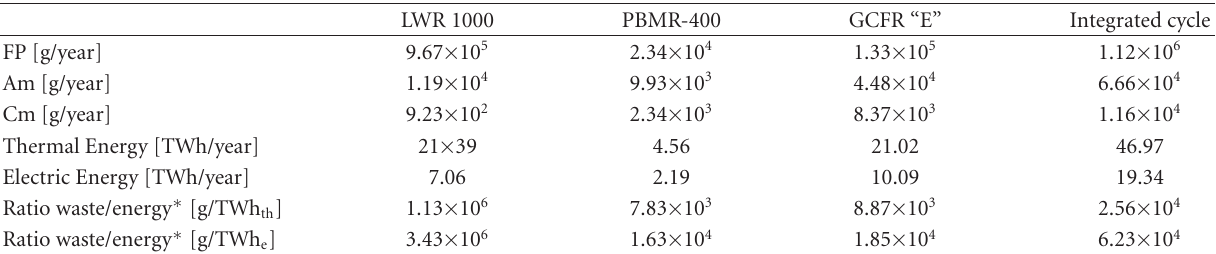
Table 7: Waste per unit energy: comparison (chain composed of 1 GCFR “E”, 1.3 PBMR-400, 0.806 LWR).